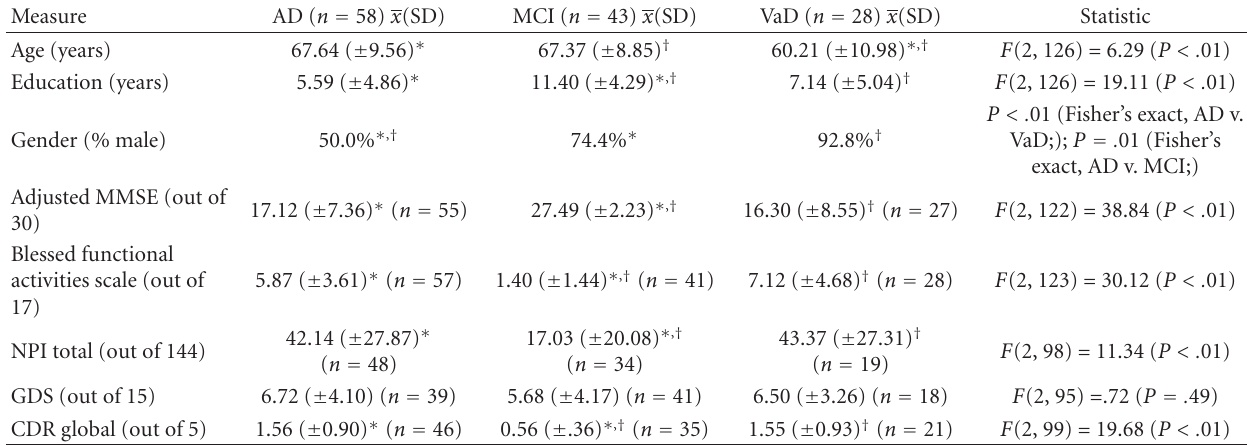
Table 3: Comparison of demographic and clinical measures among those with Alzheimers disease (AD), mild cognitive impairment (MCI), and vascular Dementia